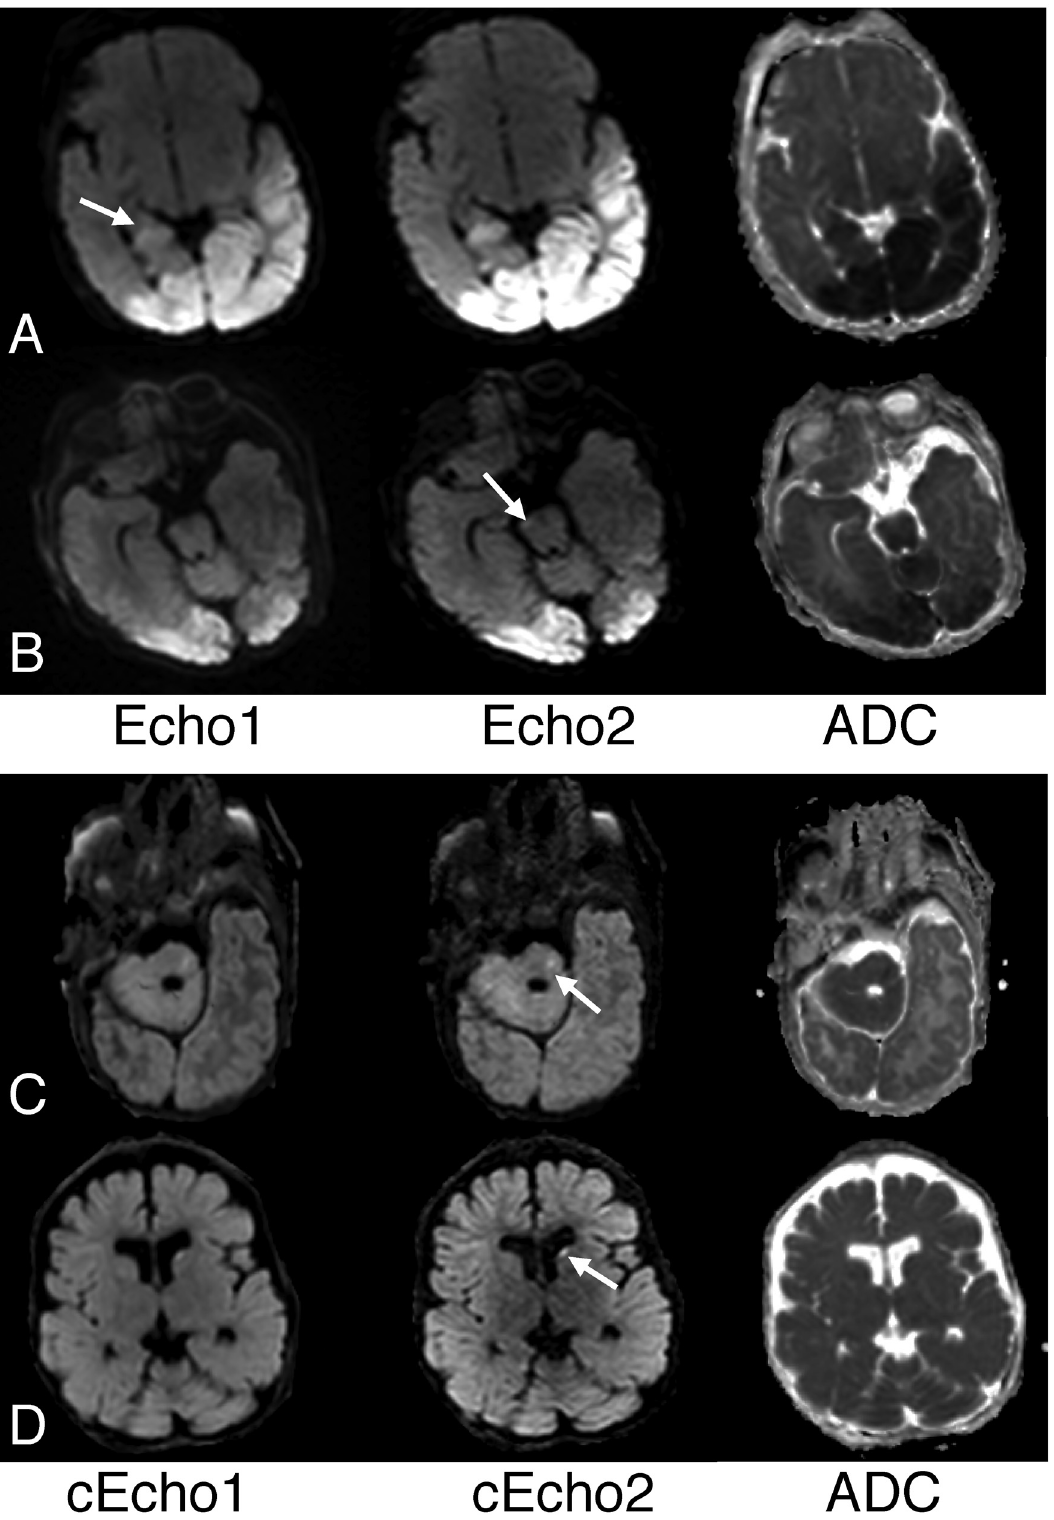
Fig 6. Examples of false negatives, or lesions missed by either of the reviewers. A. While both reviewers identified various lobar brain regions of reduced diffusivity affected by hypoglycemia in this 9-day old male infant, right hippocampal involvement was noted on Echo2 and cEcho2 (not shown) but